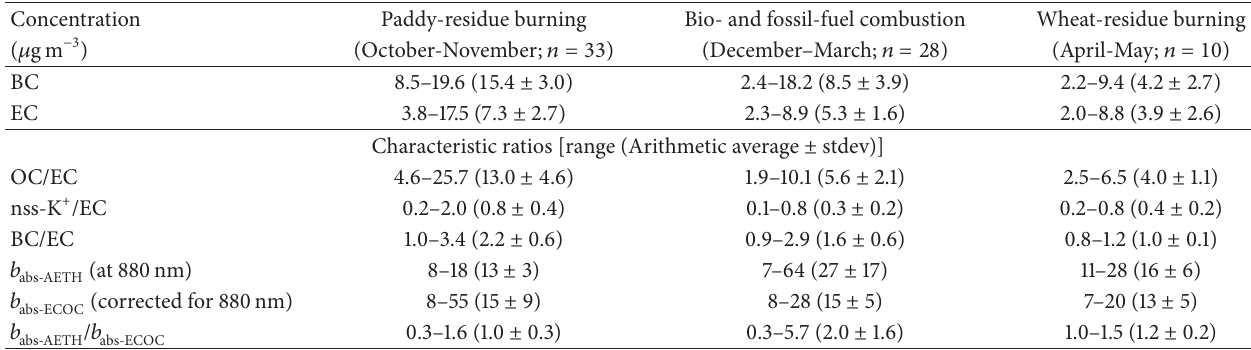
Table 1: Ambient concentration and optical characteristics of black carbon (BC) and elemental carbon (EC) from different emissions in the Indo-Gangetic Plain